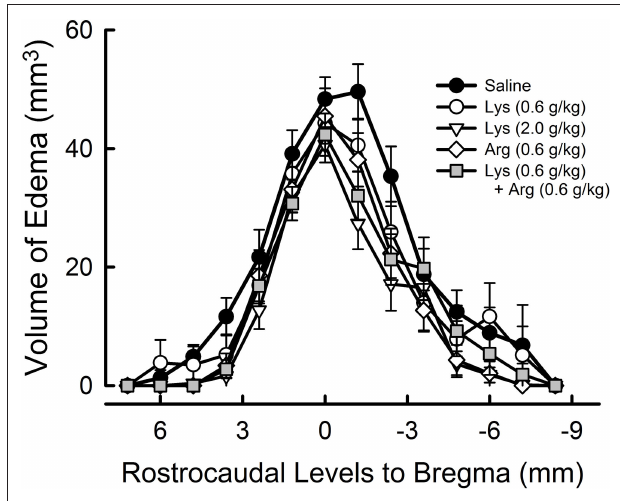
FIgure 4 | rostrocaudal extension of cerebral edema. The value 0 represents the bregma position in the antero-posterior axis, with more anterior parts represented by positive values and more posterior parts represented by negative values. Note that the extent of cerebral edema appeared to be reduced in overall levels by administration of lysine (Lys), arginine (Arg), or their combination.